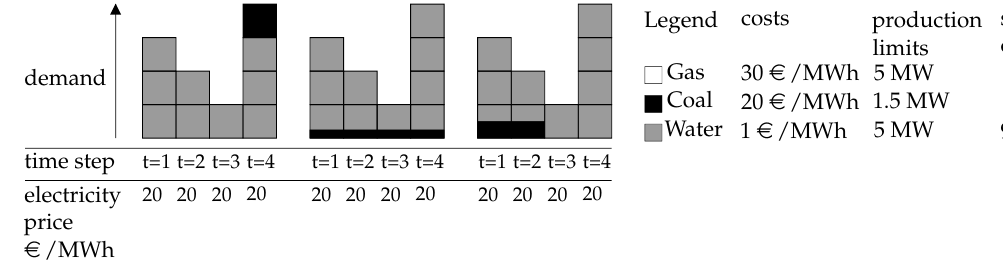
Figure 2. Price building in a deterministic optimisation model.